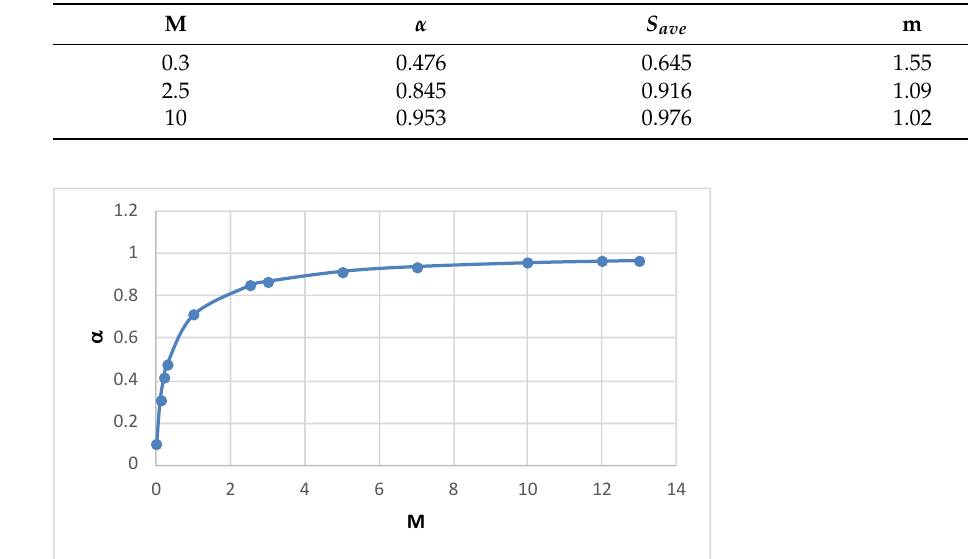
Table 1. Mobility ratios with α values and the corresponding average saturations and tangents.